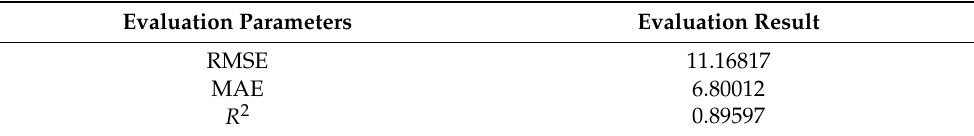
Table 5. Evaluation results of ATC workload estimation model based on XGBoost.